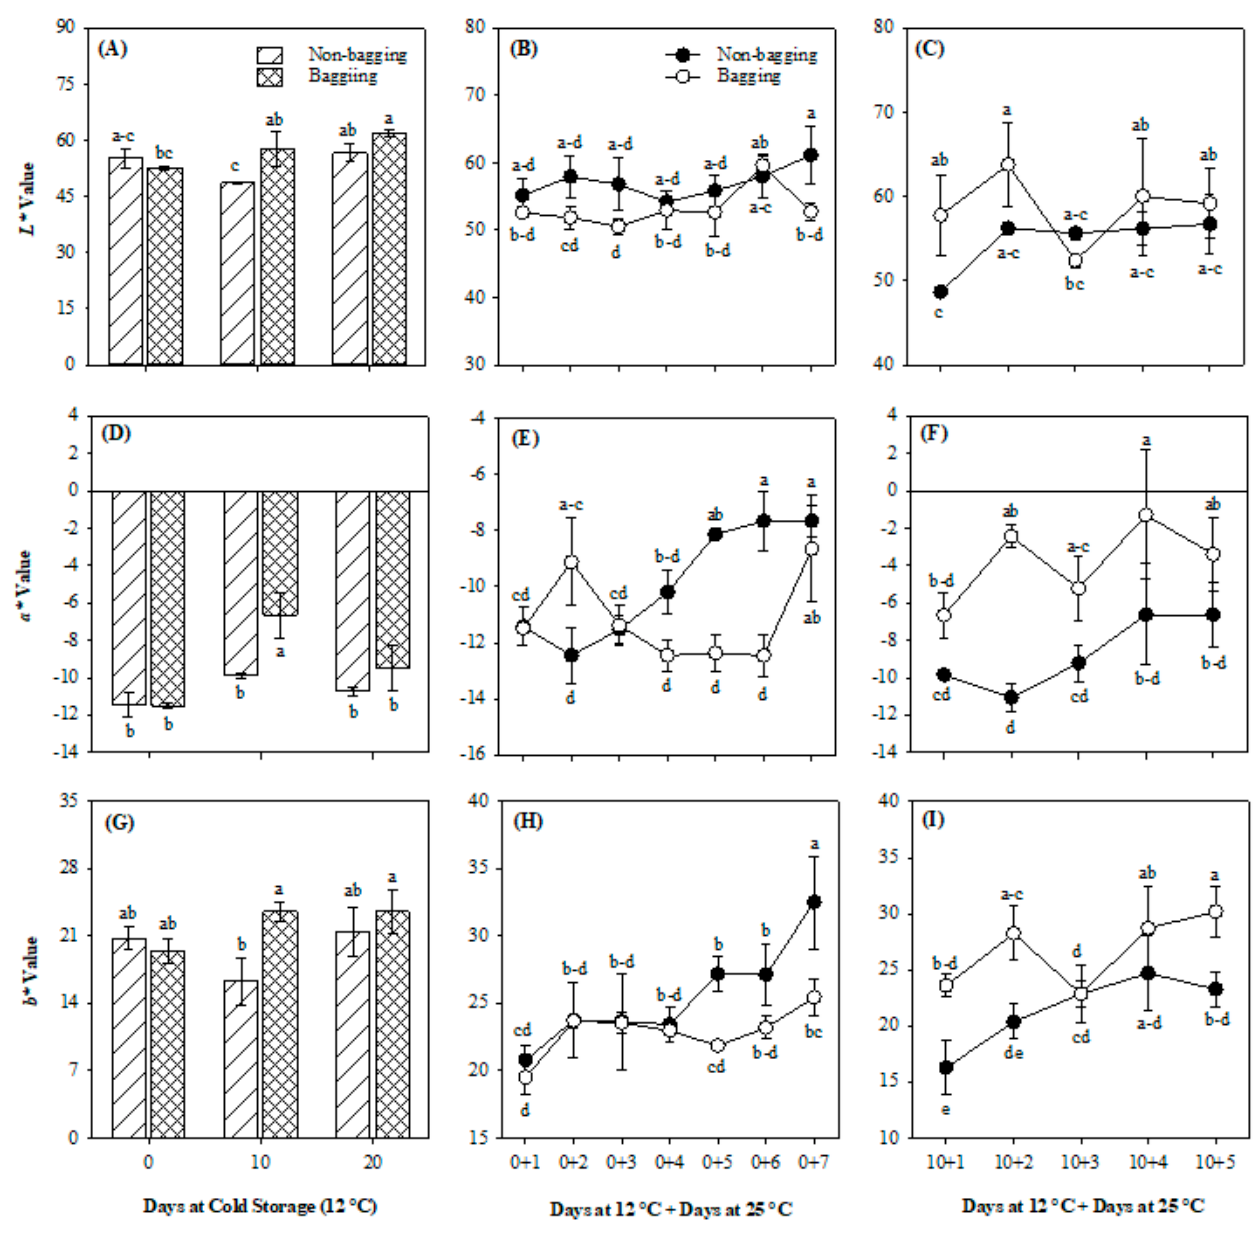
(Figure 2E). During ambient storage, 10 d cold-stored bagged fruits had significantly higher values of a* on the second day (2 d) and fourth day (4 d) (Figure 2F). As for the b* value is concerned, only 10 d cold-stored fruits exhibited significant changes due to bagging treatments (Figure 2G). During ambient storage, 0 d cold-stored non-bagged fruits had a significantly higher value of b* on the fifth day (5 d) and seventh day (7 d) as compared to bagged fruits (Figure 2H). While 10 d cold-stored bagged fruits showed higher values of b* on the first day (1 d), second day (2 d) and fifth day (5 d) as compared to non-bagged fruits (Figure 2I).